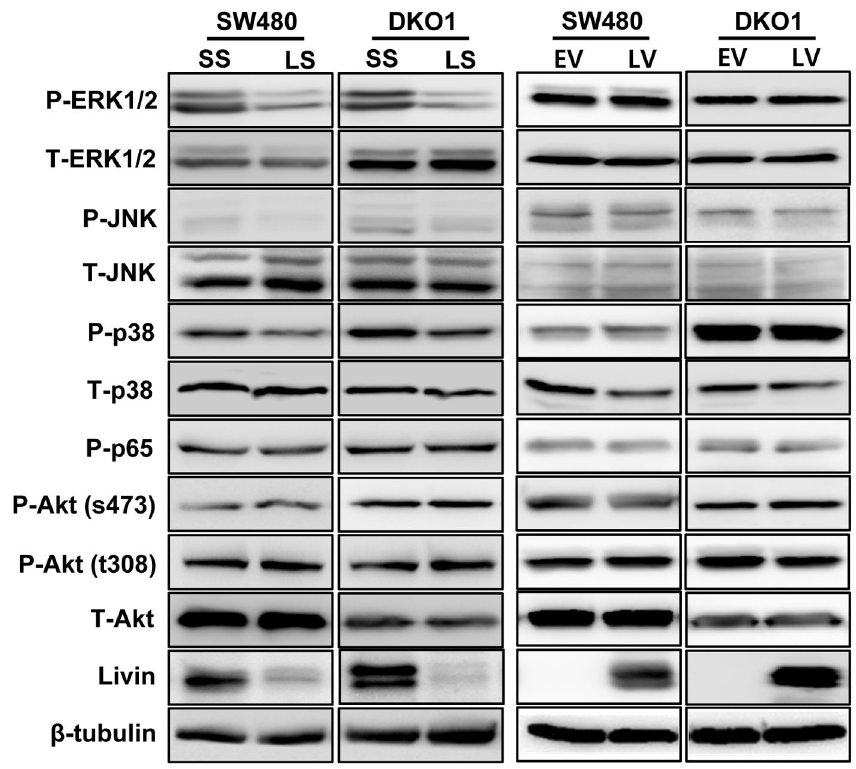
Figure 4. The impact of Livin on intracellular signaling pathways involved in apoptosis and cell cycle arrest of human colorectal cancer cells. The phosphorylation levels of ERK1/2, JNK and p38 decreased following Livin knockdown of SW480 and DKO1 cells. But Akt and p65 the phosphorylation levels showed no change following Livin knockdown. Additionally, ERK1/2, JNK, p38, Akt and p65 phosphorylation levels were not changed by overexpression of Livin. SS; scramble siRNA, LS; Livin siRNA, EV; Empty-pcDNA3.1, LV; pcDNA3.1-Livin. doi: